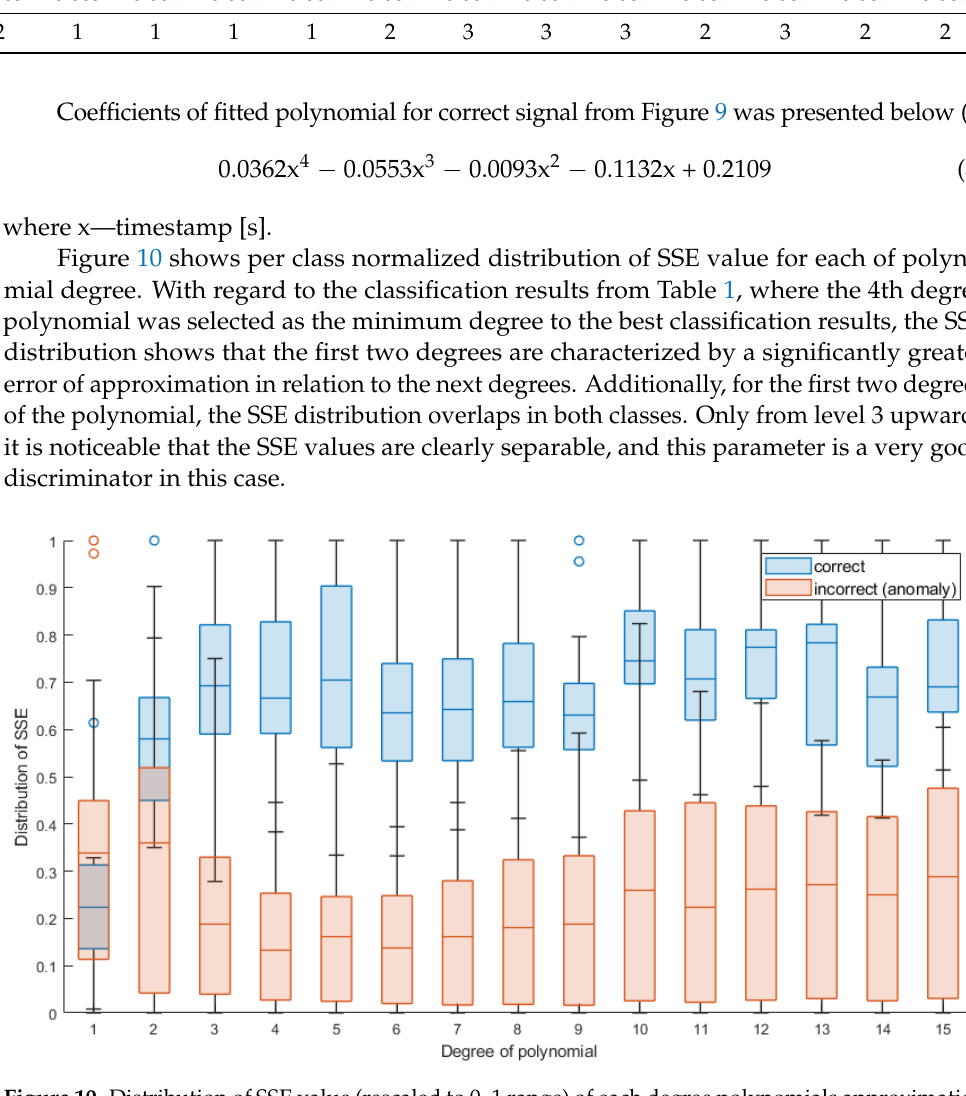
Figure 10. Distribution of SSE value (rescaled to 0–1 range) of each degree polynomials approximation of the displacement signals (for case of 220 samples).